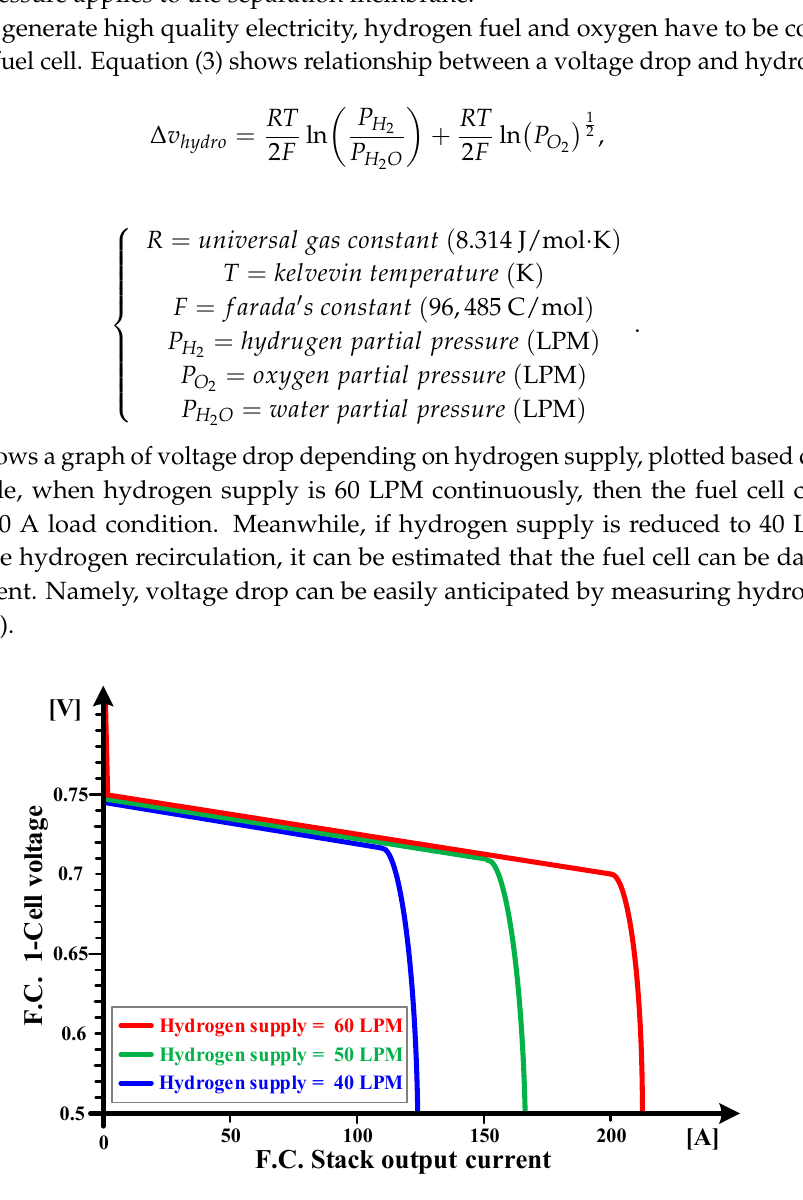
Figure 3. Fuel cell stack waveforms for conventional control method during hydrogen recirculation.